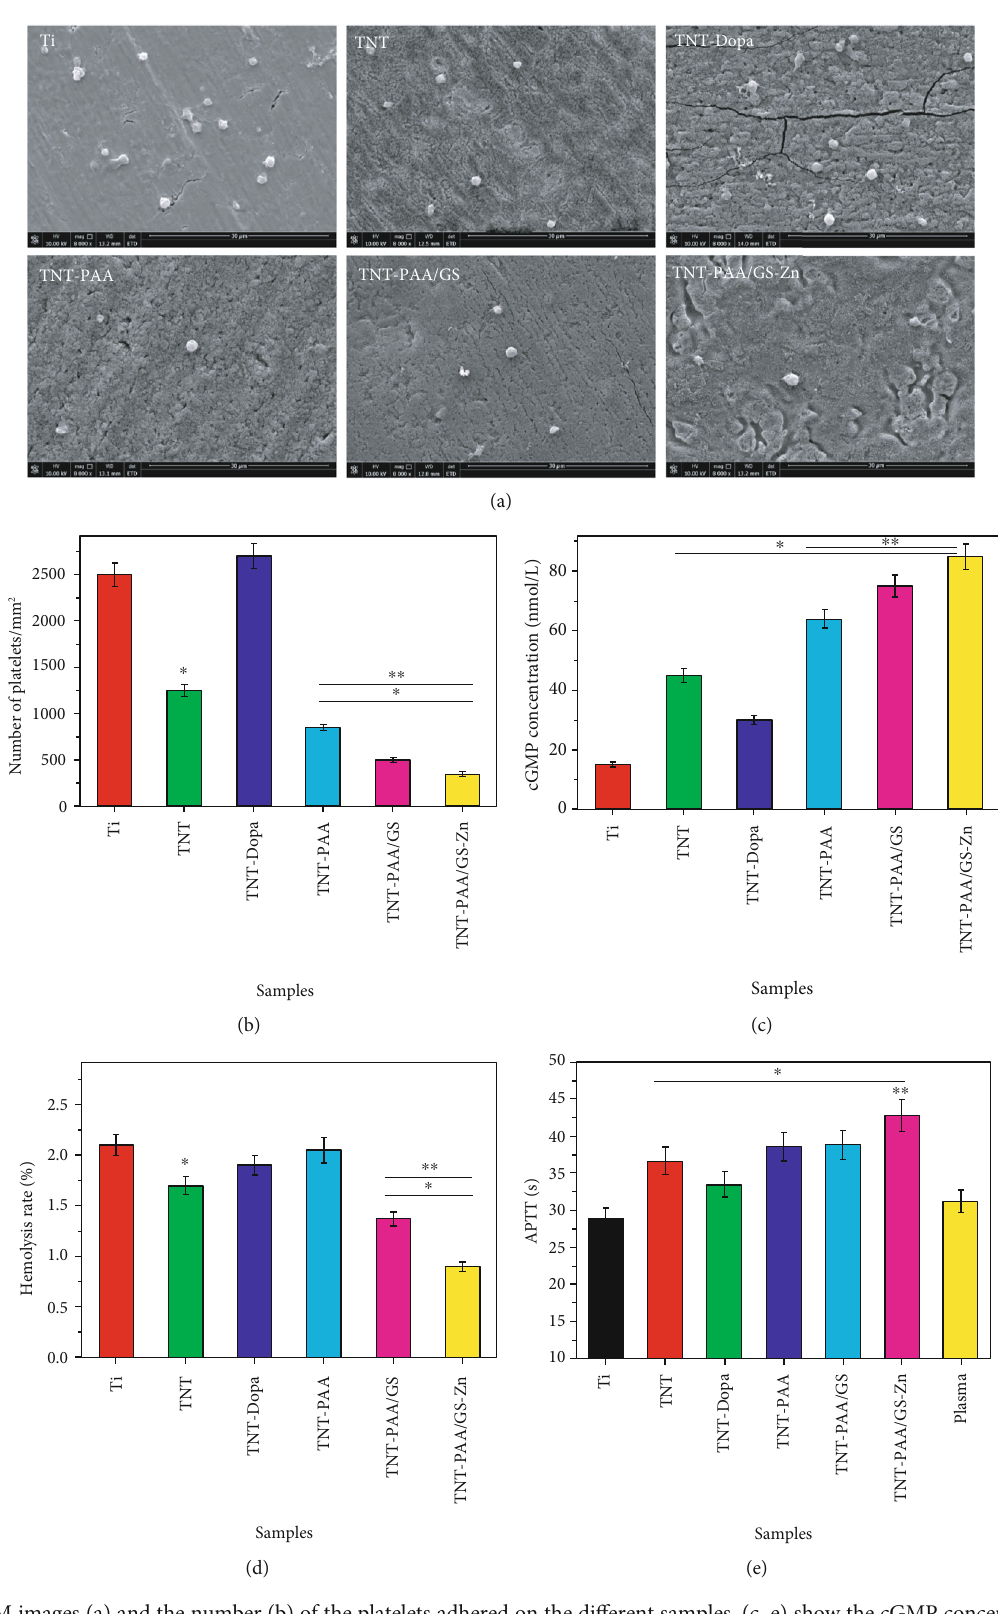
Figure 4: SEM images (a) and the number (b) of the platelets adhered on the di ff erent samples. (c – e) show the cGMP concentration of the attached platelets, hemolysis rate, and APTT of the di ff erent samples, respectively. Statistical di ff erences are indicated by ∗ p < 0 : 05 compared with the Ti group and ∗∗ p < 0 : 05 compared with the Ti and TNT